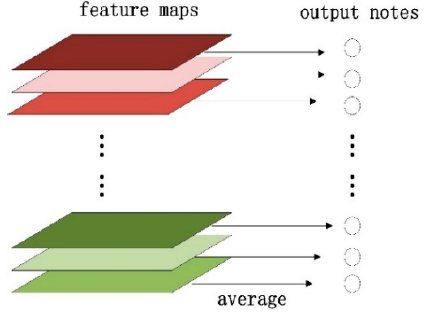
Figure 4. Global average pooling.